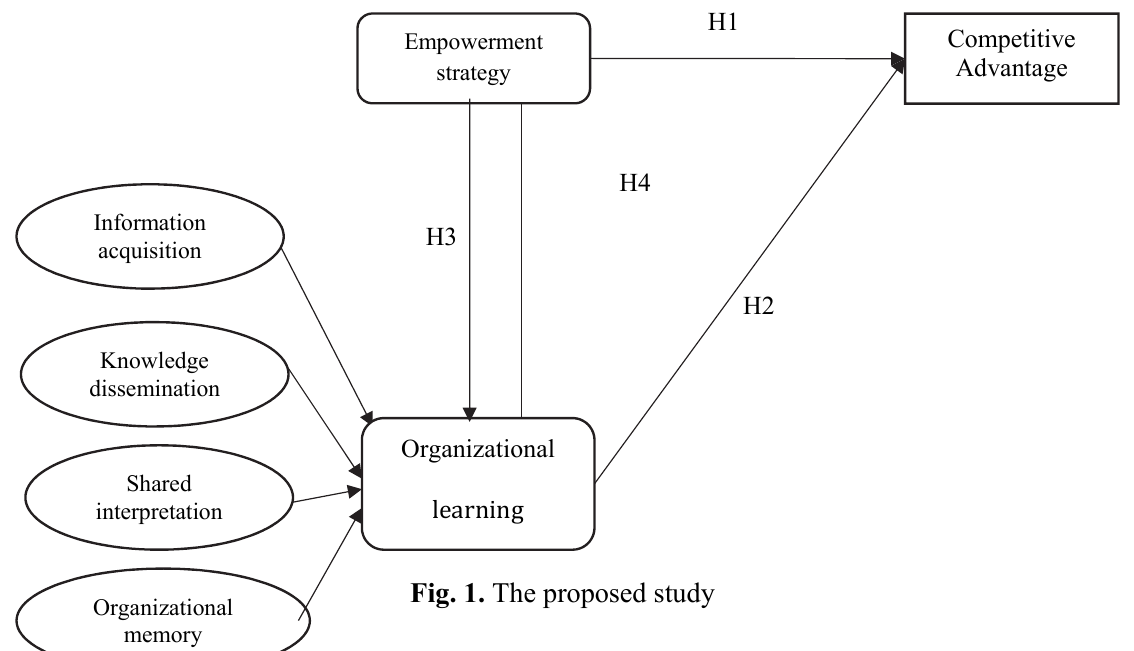
Fig. 1. The proposed